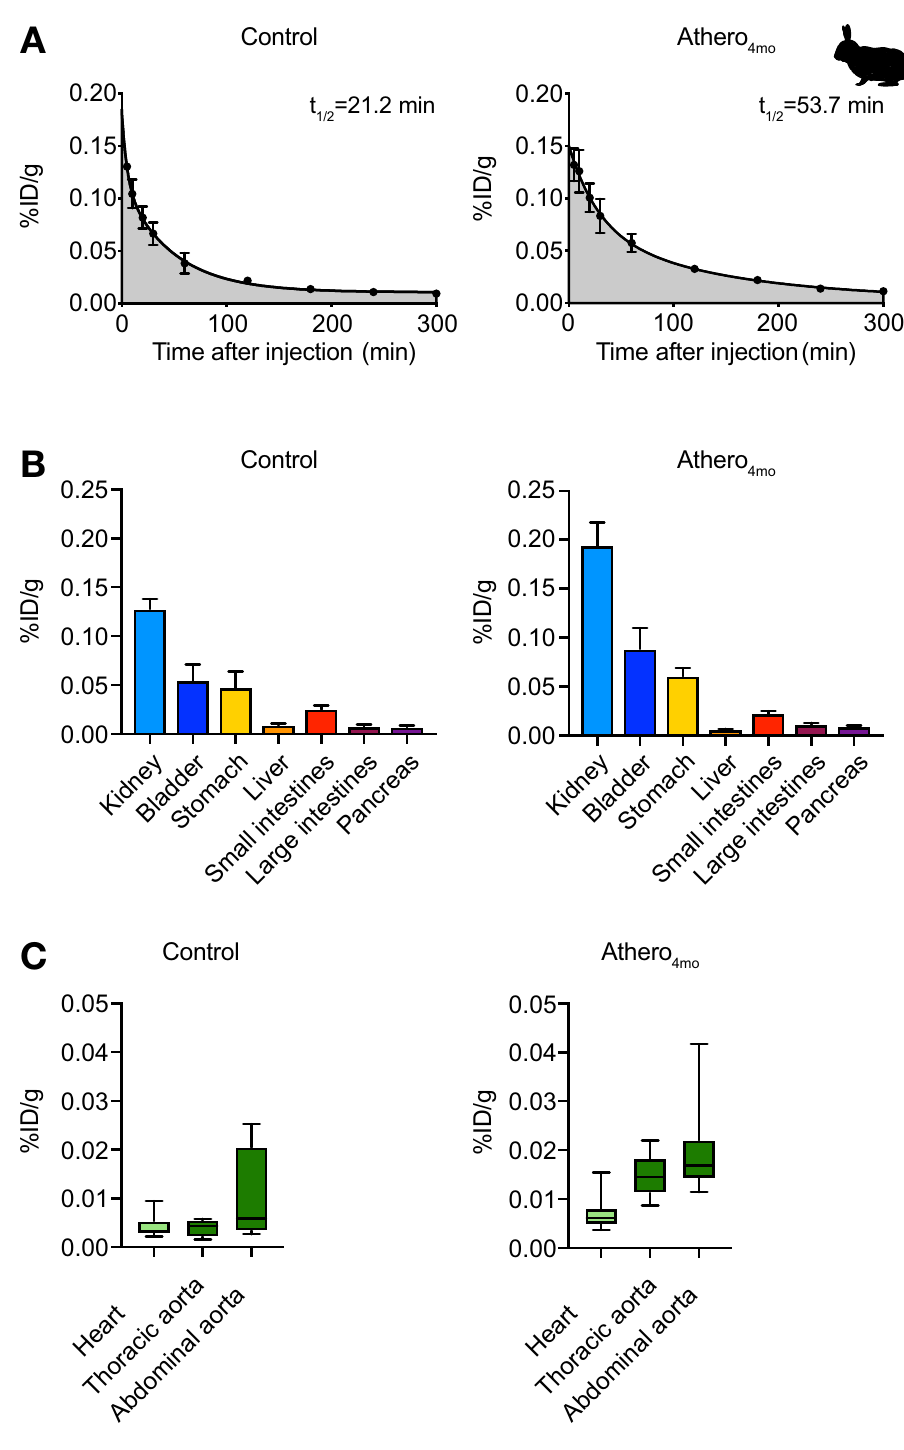
Figure 5. [ 68 Ga]Ga-DOTATATE pharmacokinetics and biodistribution in rabbits. ( A ) Blood time-activity curve of [ 68 Ga]Ga-DOTATATE-infused control (left) and athero 4mo (right) rabbits. Controls N = 2 and athero 4mo N = 3. Data are presented as mean ± standard error of the mean. ( B ) Ex vivo quantification of [ 68 Ga]Ga-DOTATATE uptake in urinary and digestive organs of rabbits at 200 min after tracer injection, as determined by gamma counting. Data are presented as mean ± standard error of the mean. Controls N = 6 and athero 4mo N = 9. ( C ) Ex vivo quantification of [ 68 Ga]Ga-DOTATATE uptake in the heart, thoracic and abdominal aorta 200 min after tracer injection, as determined by ex vivo gamma counting. Controls N = 6 and athero 4mo N = 9. Data are presented as median (interquartile range). ID: injected dose; t 1/2 :